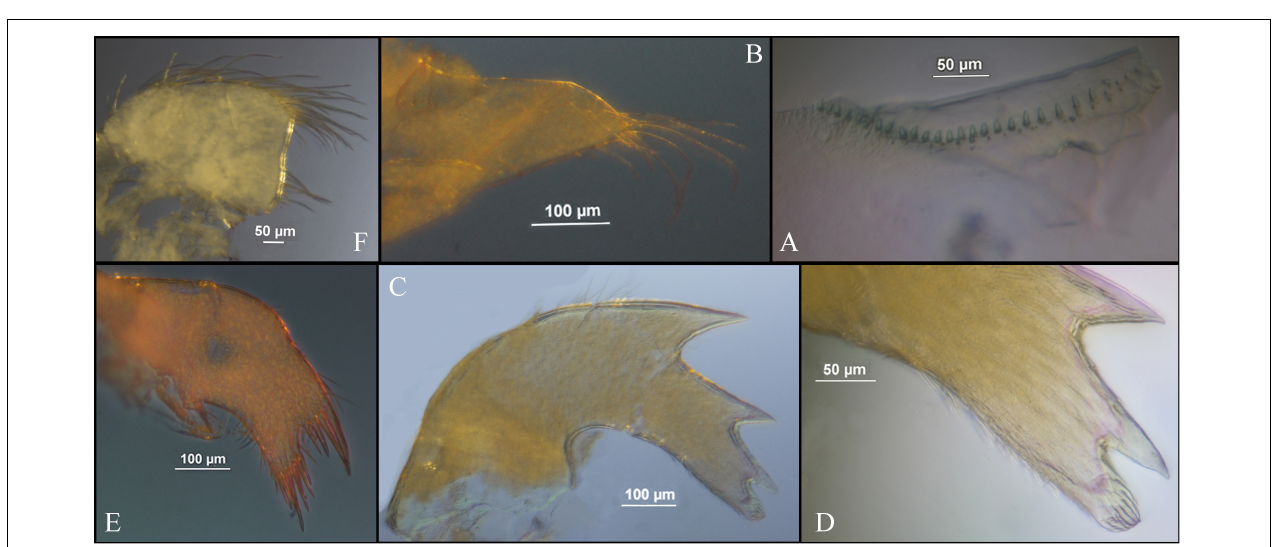
FIGURE 3 | Arcoscalpellum angularum sp. nov. holotype. (A) Inner edge of labrum. (B) Palp. (C) Mandible. (D) Inferior angle of mandible. (E) Maxillule. (F) Maxilla.